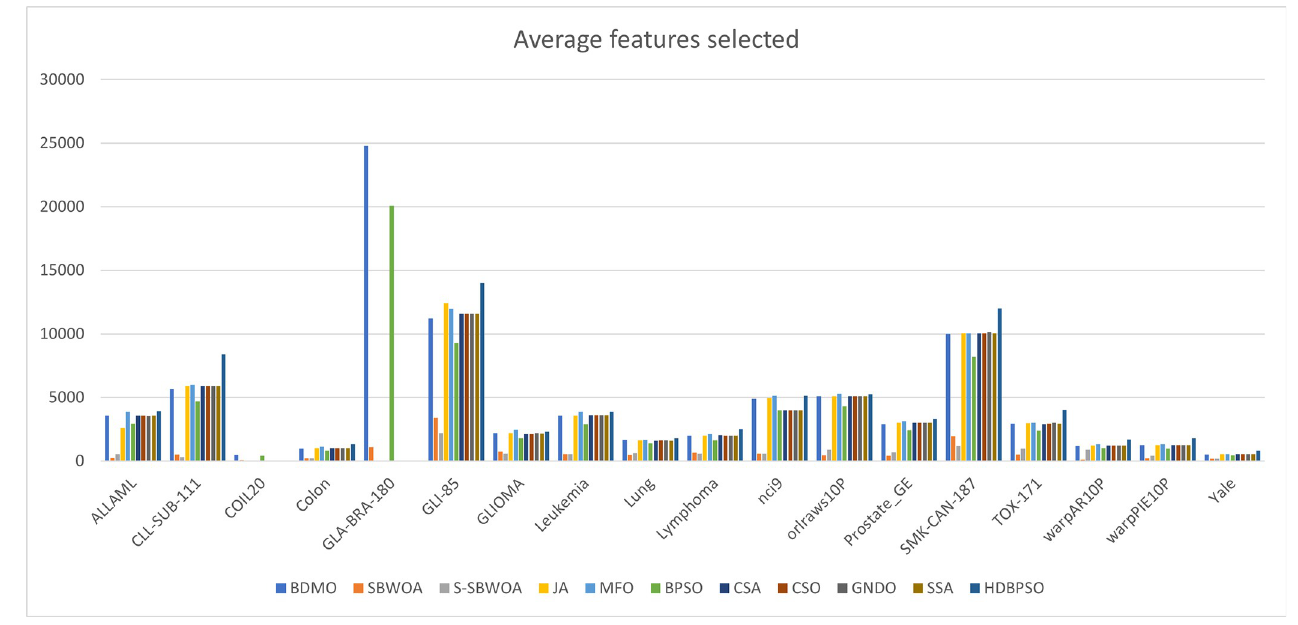
Fig 4. Average feature selected by BDMO and other